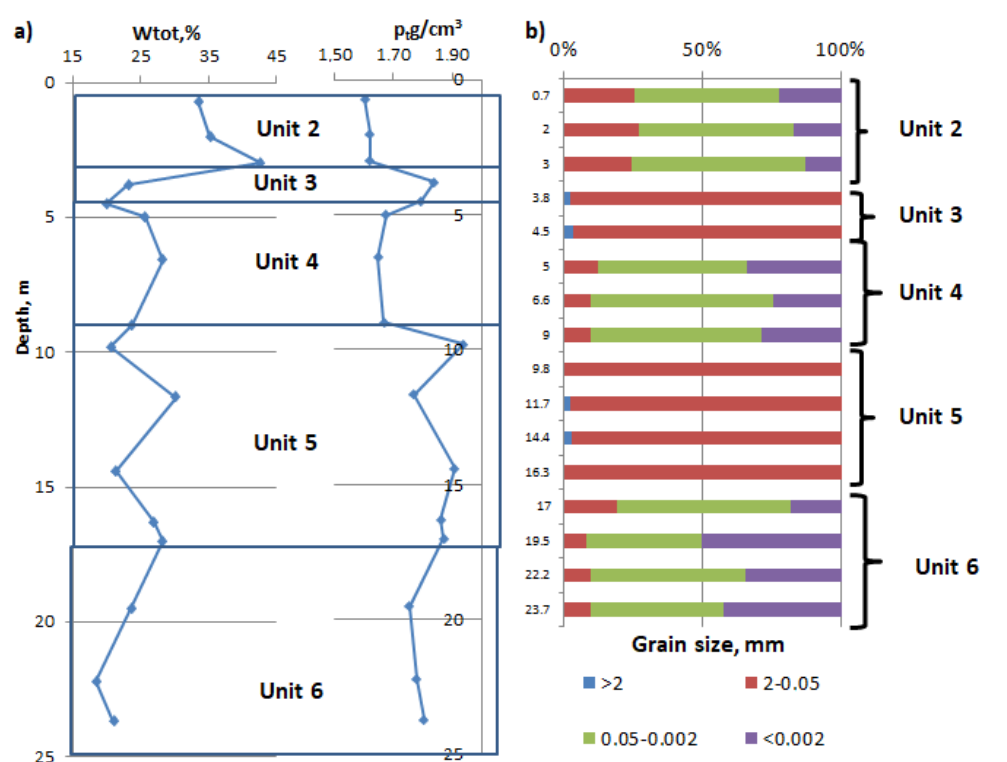
Figure 6. Characteristics of frozen soils at the Baydaratskaya Bay study site: ( a ) water content W tot and soil density ρ t vs. depths, ( b ) grain size vs. depth.